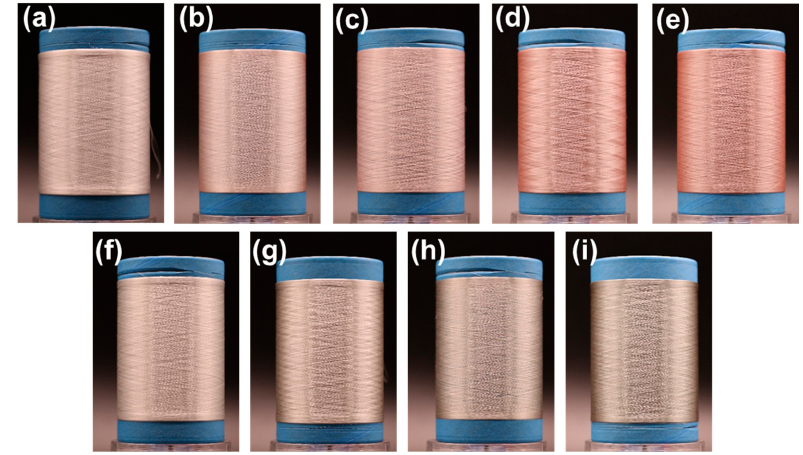
Figure 7. Digital photos of PET and PET-based fibers. ( a ) PET, ( b ) PET/Cu 2 O@ZrP-I-0.1%, ( c )